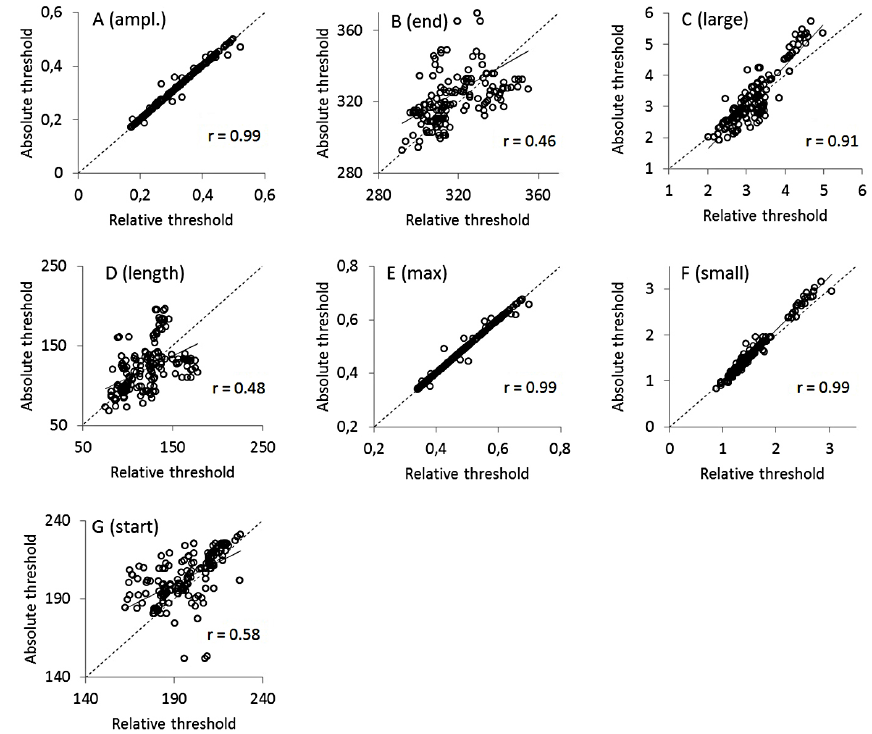
Figure 3. Relationship between growing season metrics calculated by using relative thresholds ( x axis) and absolute thresholds ( y axis) in